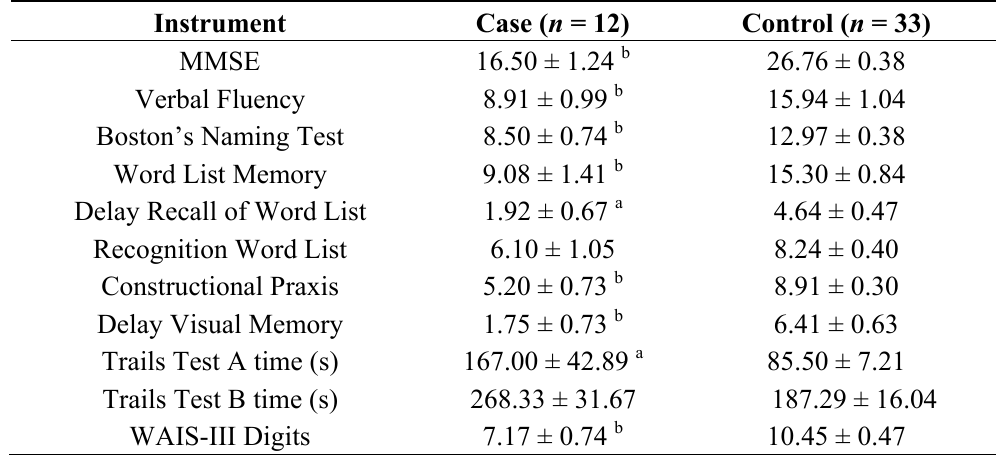
Table 3. Cognitive performance of the studied groups in the different applied